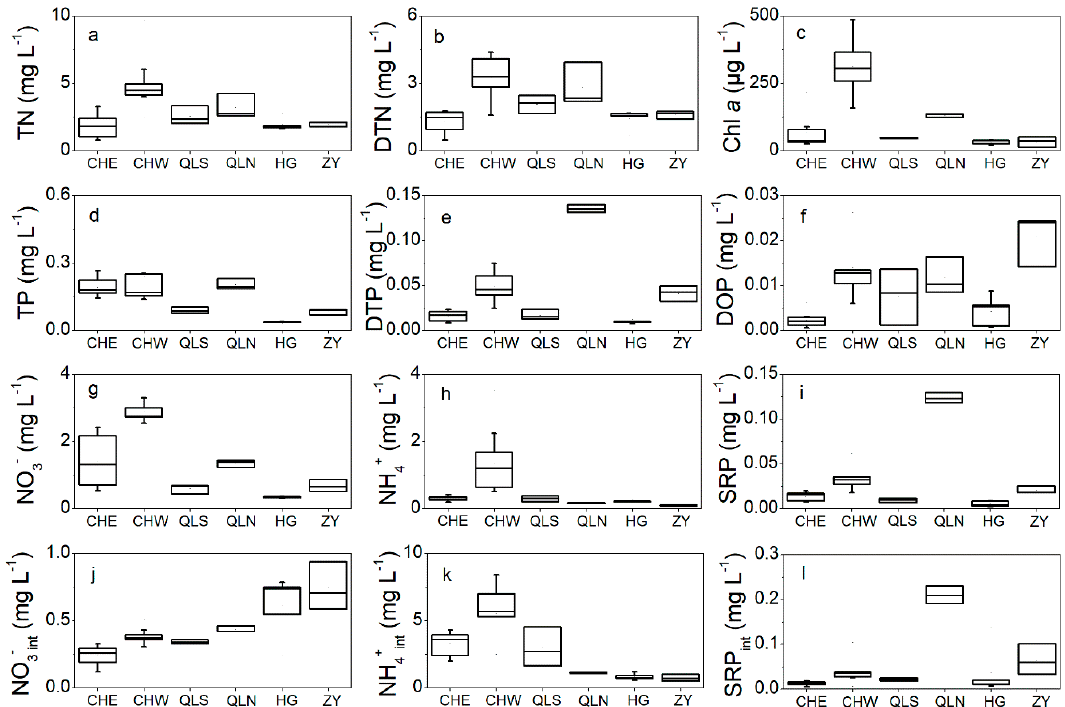
Figure 2. Boxplots showed the mean of chemical parameters of water column and interstitial water in the east (CHE) and west basins (CHW) of Lake Chaohu, south (QLS) and north (QLN) basins of Lake Qingling, Lake Houguan (HG), and Lake Zhiyin (ZY). Horizontal lines indicate the median, small squares show the mean, asterisks indicate the outliers, the boxes give the 25th and 75th percentiles, and bars show the range from the 5th to 95th percentiles. ( a ) TN, total nitrogen; ( b ) DTN, dissolved total nitrogen; ( c ) Chl a ; ( d ) TP, total phosphorus; ( e ) DTP, dissolved total phosphorus; ( f ) DOP, dissolved organic phosphorus; ( g ) NO 3 − ; ( h ) NH 4+ ; ( i ) SRP, soluble reactive phosphorus; ( j ) NO 3 − int , nitrate in interstitial water; ( k ) NH 4+int , ammonium in interstitial water; ( l ) SRP int , soluble reactive phosphorus in interstitial water).